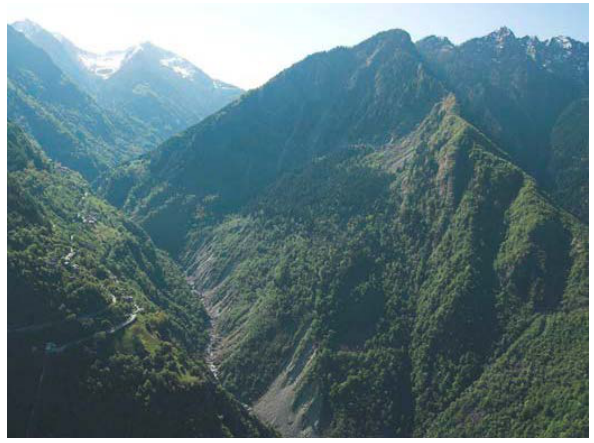
Figure 2. The “Pruna